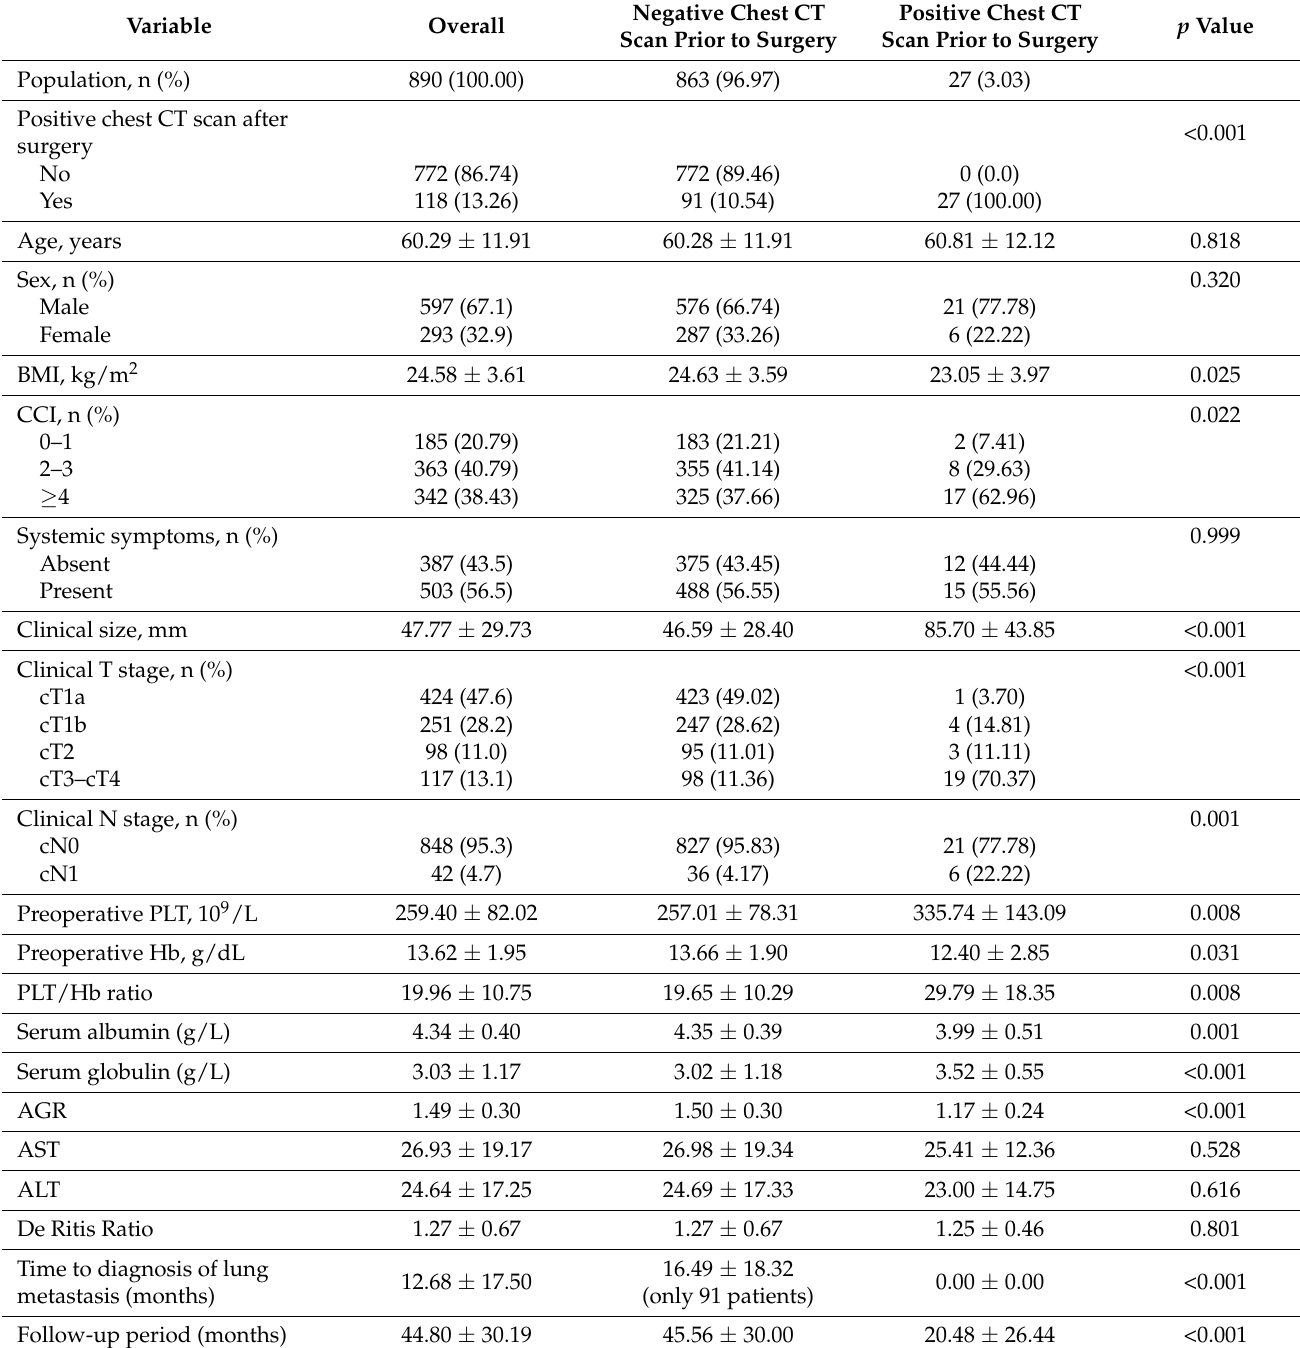
Table 1. Clinical characteristics of